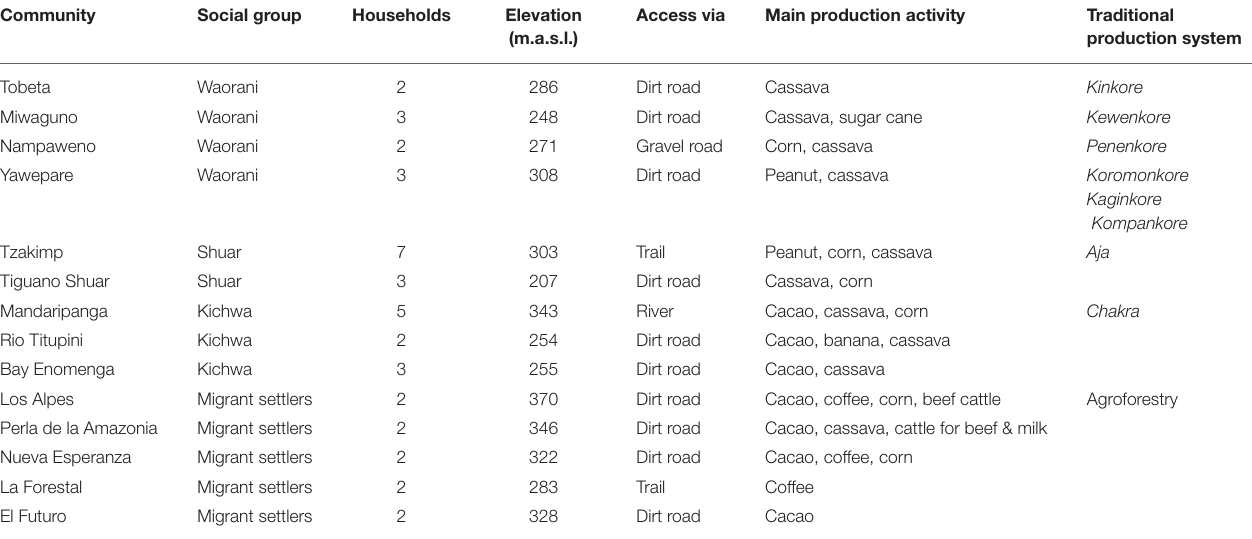
TABLE 1 | Communities in the study sample, with social groups—Waorani, Shuar, Kichwa, and migrant settlers—in the Yasuní Biosphere Reserve, Ecuador. Community